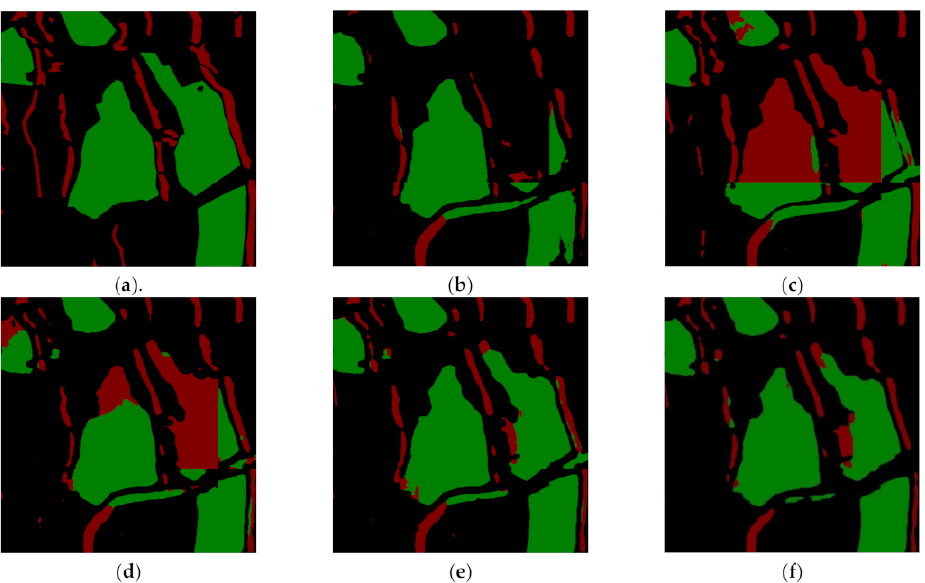
Figure 12. Local segmentation results of di ff erent networks proposed in this paper. ( a ) The ground truth. ( b ) Lee_Encoder_MFEF1 result. ( c ) Encoder_MFEF1 result. ( d )